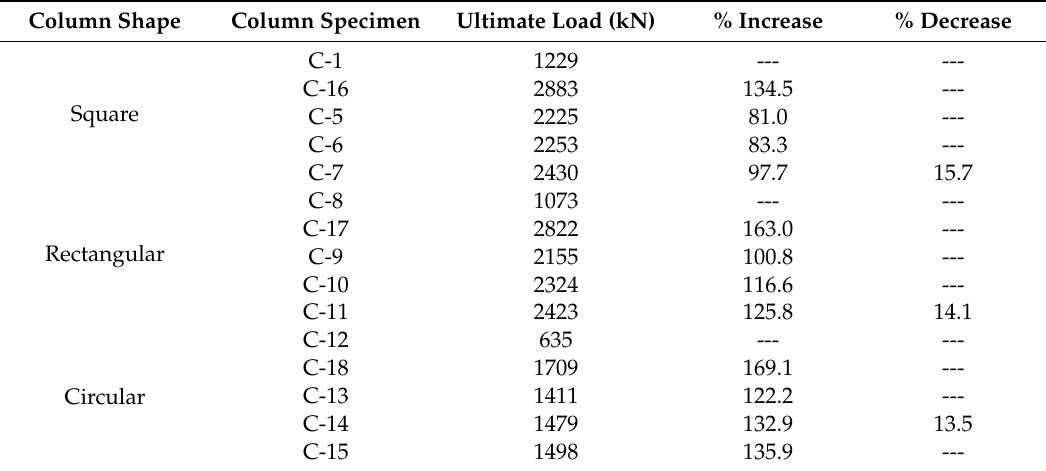
Table 4. Summary of RC columns strengthened by RC